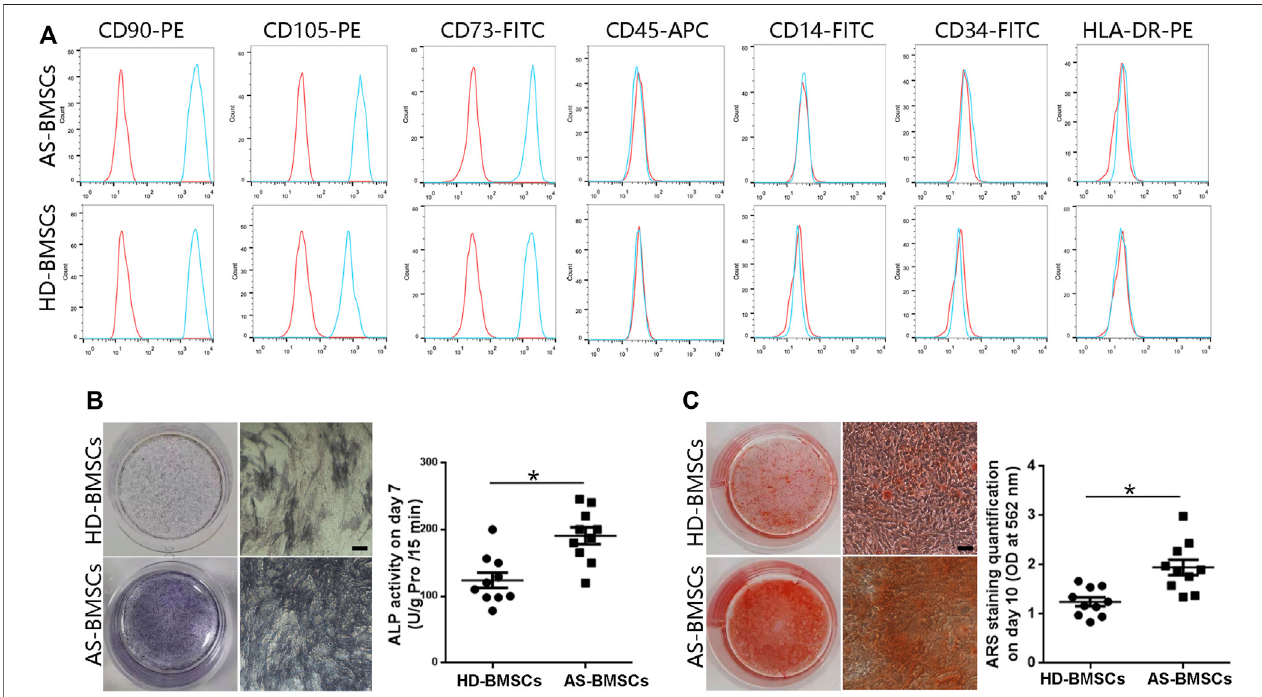
FIGURE 1 | Immunophenotypes and osteogenic capacities of HD-BMSCs and AS-BMSCs. (A) . HD-BMSCs ( n = 10) and AS-BMSCs ( n = 10) were both positive forCD90,CD105,andCD73andnegativeforCD45,CD14,CD34andHLA-DR. (B) .Resultsofthealkalinephosphatase(ALP)assayforHD-BMSCsandAS-BMSCson day 7 of osteogenic induction. Scale bar = 50 μ m. The quantitative ALP assay results are shown on the right. (C) . Alizarin red S (ARS) staining of HD-BMSCs and AS- BMSCsonday10ofosteogenicinduction.Scalebar=50 μ m.ThequantitativeARSstainingresultsareshownontheright.Thedataarepresentedasthemeans± SEMs. N = 10 per group. * p <